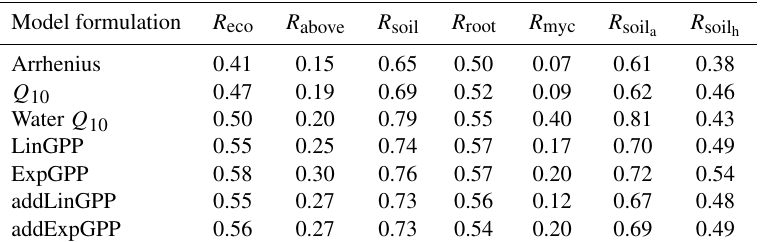
Table 5. Average validation MEF performance for CMA-ES optimized selected literature model formulations when compared with respira- tion CO 2 flux observations.